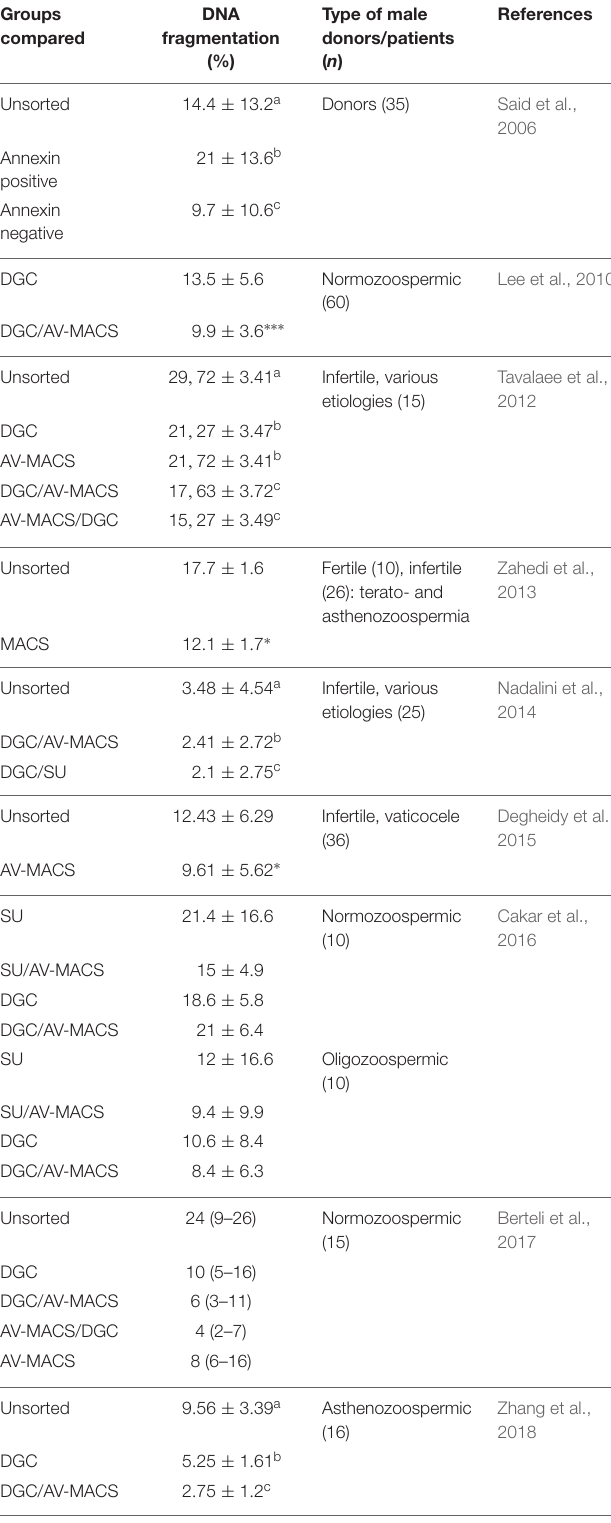
TABLE 1 | DNA fragmentation of spermatozoa selected by AV-MACS. Groups